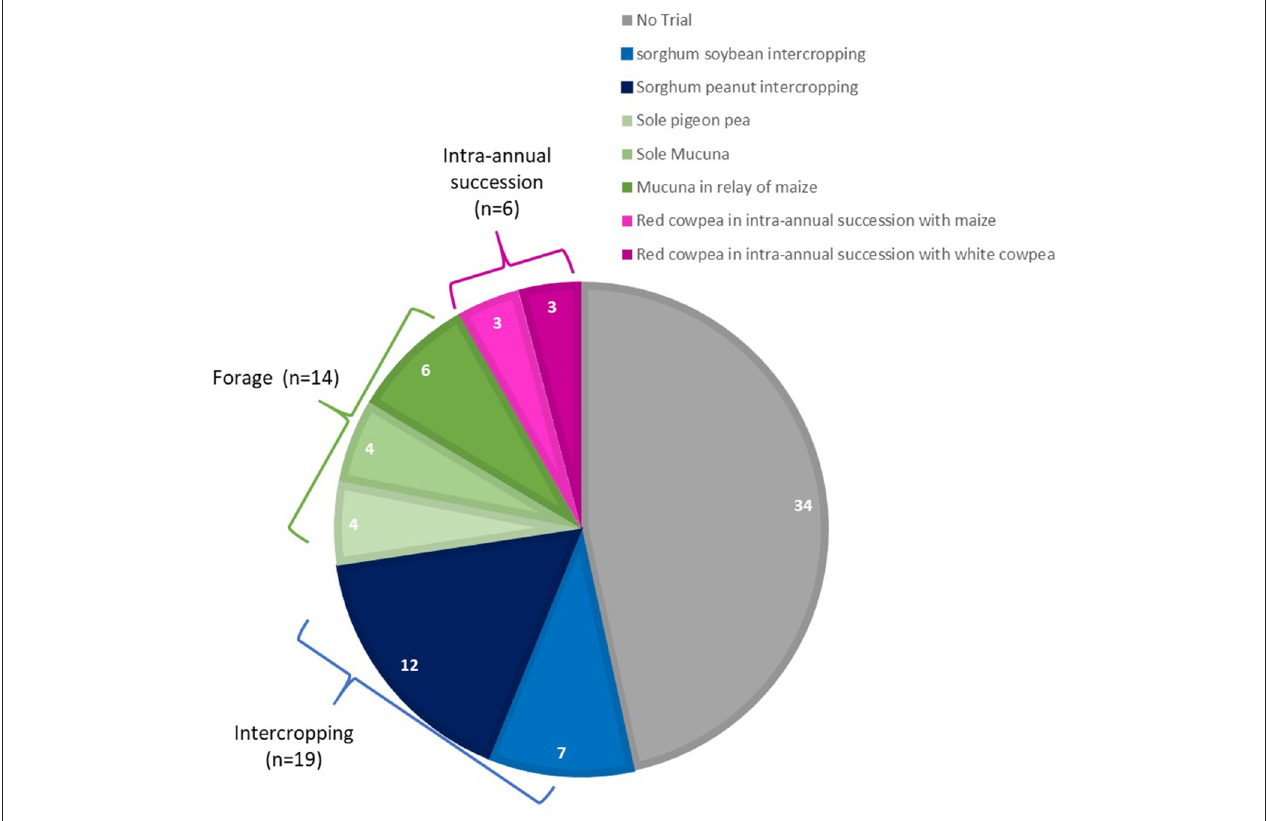
FIGURE 1 | Distribution of the 73 farmers who took part in the field days, according to the choice of ICS implemented in the Farmer Adaptation Trials. The number farmers for each type of ICS (intra-annual successions in purple, fodder crops in green, sorghum-legume intercropping in blue) are indicated in brackets.